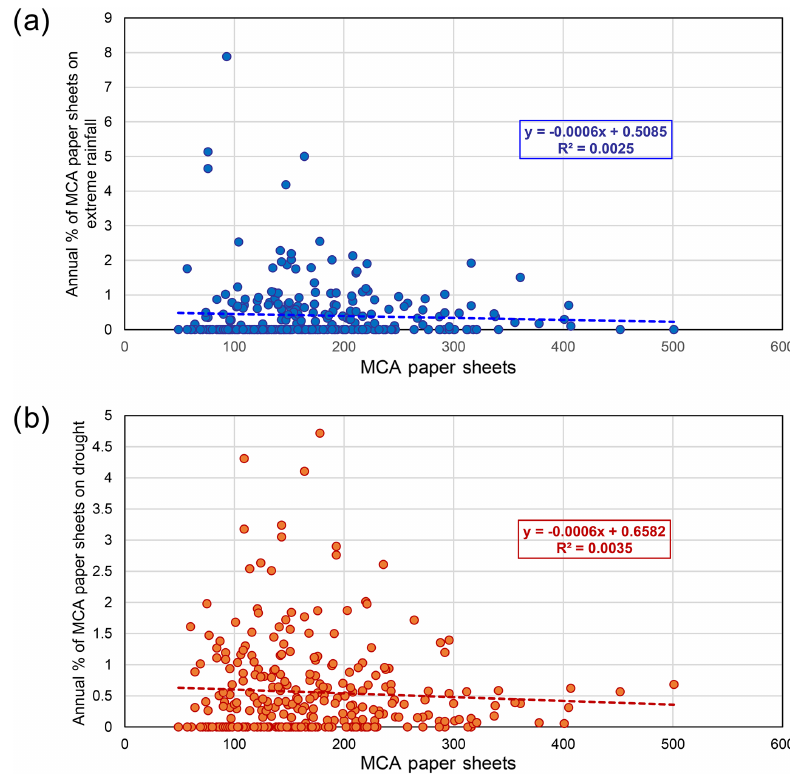
Figure A2. Relationship between the annual amount of MCA paper sheets and the annual percentage of MCA paper sheets dedicated to inform about droughts (a) and extreme rainfall (b)